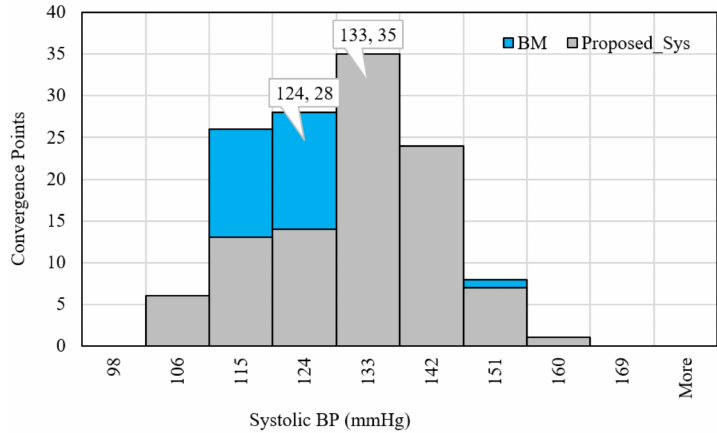
Figure 9. The histogram test of systolic BP data.